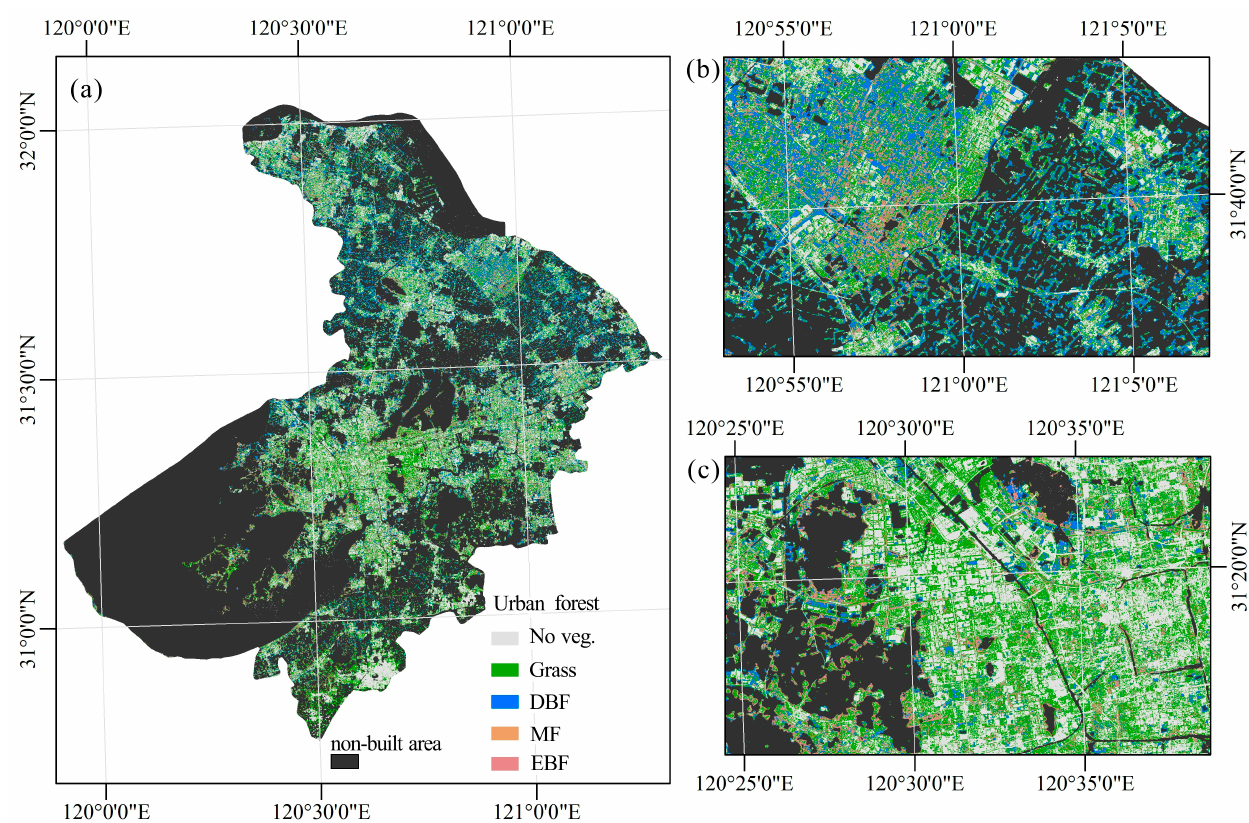
Figure 9. The distribution of urban forests in Suzhou ( a ) and its detailed views ( b , c ). Veg. is vegetation. DBF, MF, and EBF are deciduous broadleaf forests, mixed forests, and evergreen broadleaf forests.